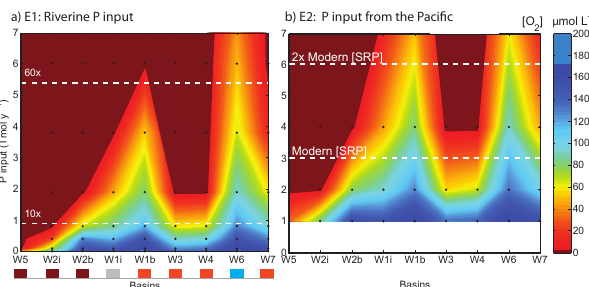
Fig. 4. Oxygen concentrations versus riverine P input for (a) ex- periment E1 and (b) experiment E2. The basins of the model are W5 (southern coast), W2 (southern open ocean), W1 (central open ocean), W3 (Western Interior Seaway), W4 (northern coast), W6 (north-eastern coast) and W7 (Tethys gateway), and i , b are the in- dexes for intermediate and bottom waters. The levels of P input are indicated relative to the standard run (dashed horizontal white lines, where, for example, 10 × indicates a P input that is 10-fold higher than in the standard run). The colour bars below the x axis indi- cate the oxygen conditions for each basin as deduced from obser- vations for OAE2 (Fig. 1b), where dark red denotes euxinic/anoxic; orange, low oxygen/anoxic; blue, low oxygen/oxic; and grey, un- certain. In (b) , the P levels corresponding to the SRP concentration of the modern Pacific bottom water and its doubling are indicated (dashed horizontal white